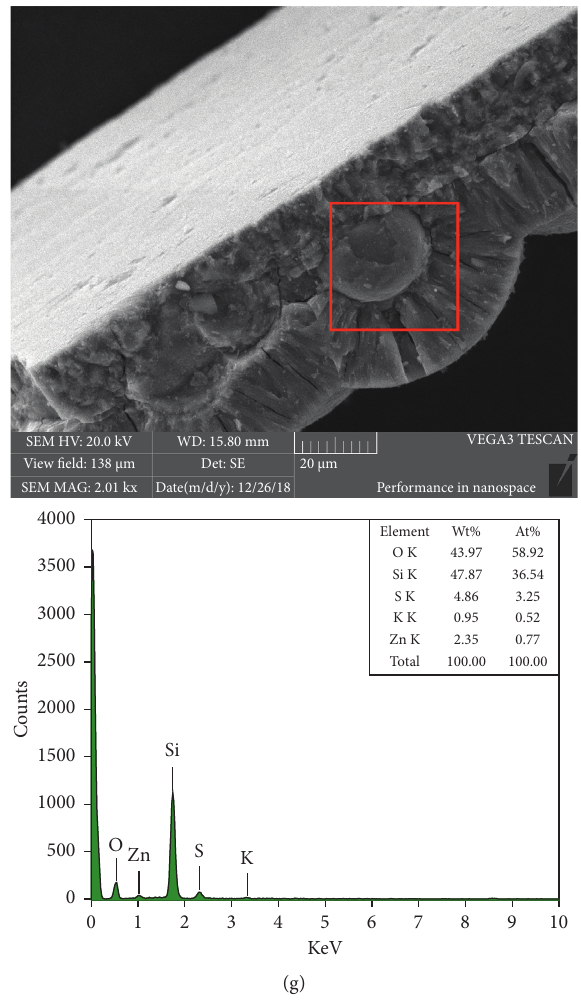
Figure 9: SEM-EDS analysis of volatile condensates at 1,200 °